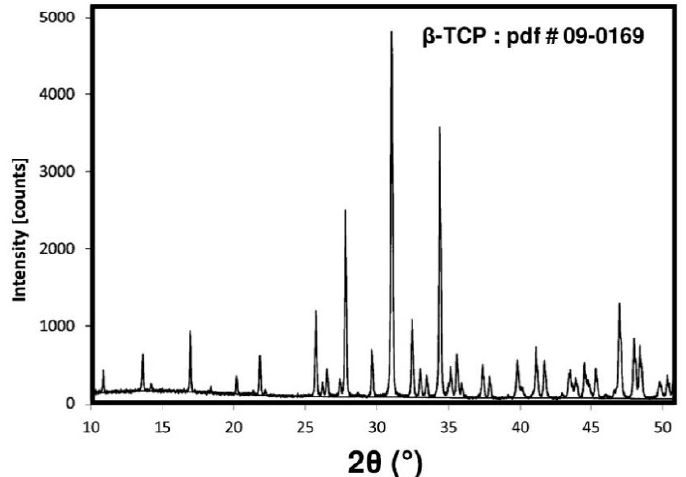
Figure 7. XRD pattern of β -TCP. Reprinted and adapted with permission from Ref. [114]. Copyright 2020 Elsevier.